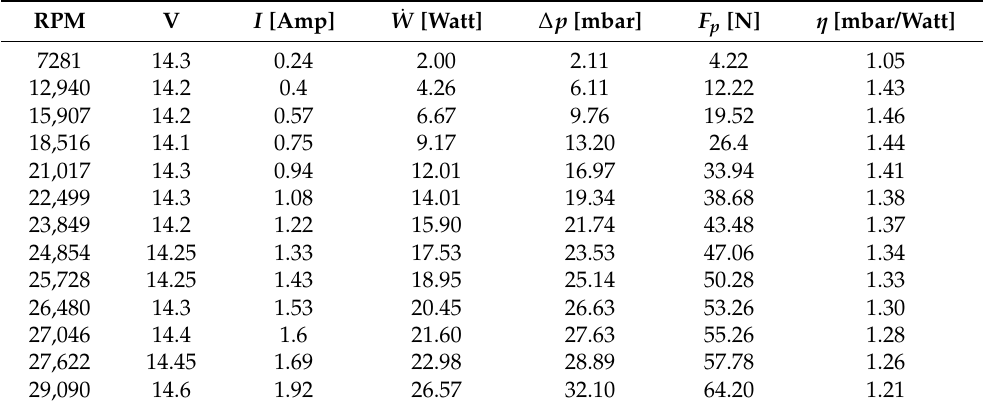
Table 5. Test rig measurements for the ORP.